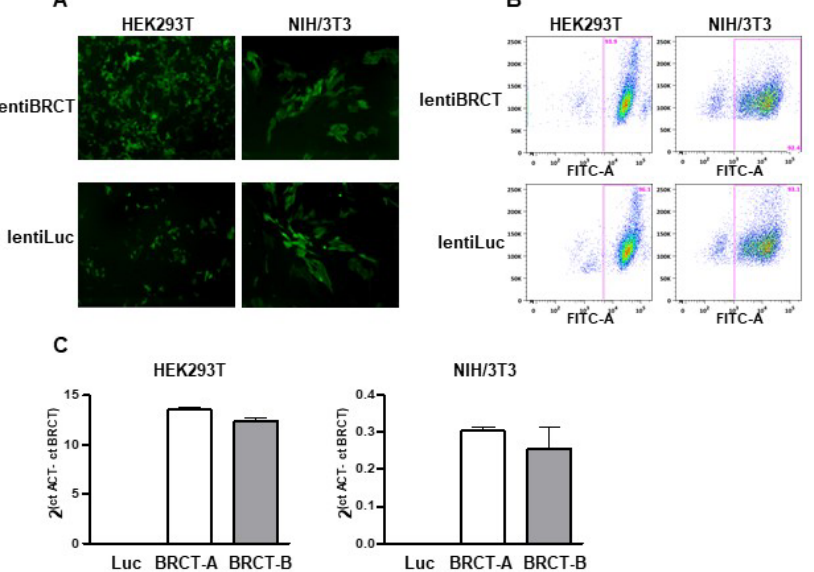
Figure 1. Production and verification of a lentivirus carrying the BRCT domain from LmjPES . To study the implication of BRCT domain from LmjPES protein in mammal cells, we first performed lentiviral particles expressing this BRCT domain (lentiBRCT) or the Luciferase protein (lentiLuc) and the ZsGreen protein. ( A ) Image obtained with the fluorescence microscope of HEK293T and NIH/3T3 cells infected with both lentiviruses, lentiBRCT or lentiLuc. ( B ) Cell sorting analysis of positive ZsGreen lentiBRCT- or lentiLuc-infected HEK293T and NIH/3T3 cells. ( C ) mRNA expres- sion levels of BRCT domain from LmjPES molecule in lentiBRCT (BRCT-A, BRCT-B) or lentiLuc (Luc), HEK293T and NIH/3T3 infected cells. The values shown in the Figure 1C represent the mean ± SD. 2.2. The Expression of BRCT Domain from LmjPES Dramatically Increased the Replication of Mammal Cells To study the replication of HEK293T and NIH/3T3 cells after the infection with ei- ther lentiBRCT or lentiLuc, we analyzed the ATP levels produced by those cells. For this purpose, we seeded 10 4 cells/100 µL medium in 96-well plates, and two days later ATP levels were quantified. In both HEK293T and NIH/3T3 cells (Figure 2), there was a sig- nificantly higher amount of ATP in lentiBRCT-infected cells compared to controls (len- tiLuc-infected cells). Figure 2. Analysis of BRCT domain from LmjPES protein expression on the capacity of mammal cells to produce ATP. ATP levels (measured as relative light unit: RLU) produced by lentiBRCT (BRCT-A, BRCT-B) or lentiLuc (Luc) infected HEK293T ( A ) and NIH/3T3 ( B ) cells. The values rep- resent the mean ±SD of sextuplicates from a representative experiment of the three carried out.